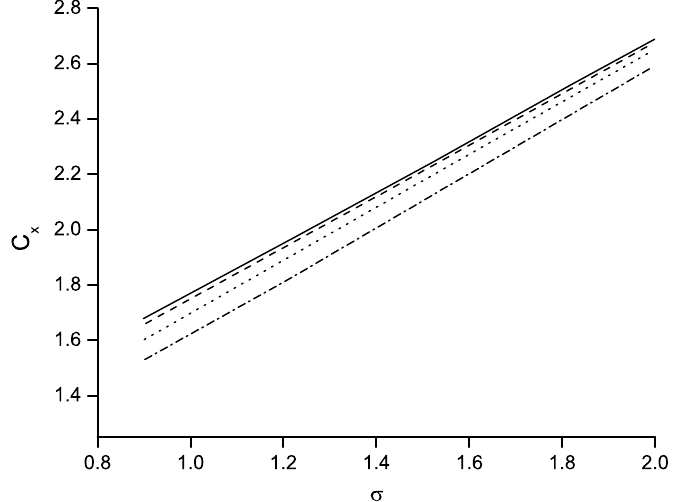
Figure 4. Drag force coefficient versus the cavitation number for radius r = 0.01 and Weber numbers: We = 1000 (solid line); We = 250 (dashed line); We = 150 (dotted line); and We = 100 (dot-dashed line). The relative difference of the cavity flow parameters for Weber numbers We = 2000 and We = 200 versus the cavitation number is shown in Figure 5 for edge radius r = 0.02. Here, ∆ h c / h c , ∆ l c / l c and ∆ C x / C x are the relative difference of the cavity width, length and force coefficient, respectively. It can be seen that, for a smaller cavitation number, the effect of surface tension is larger.